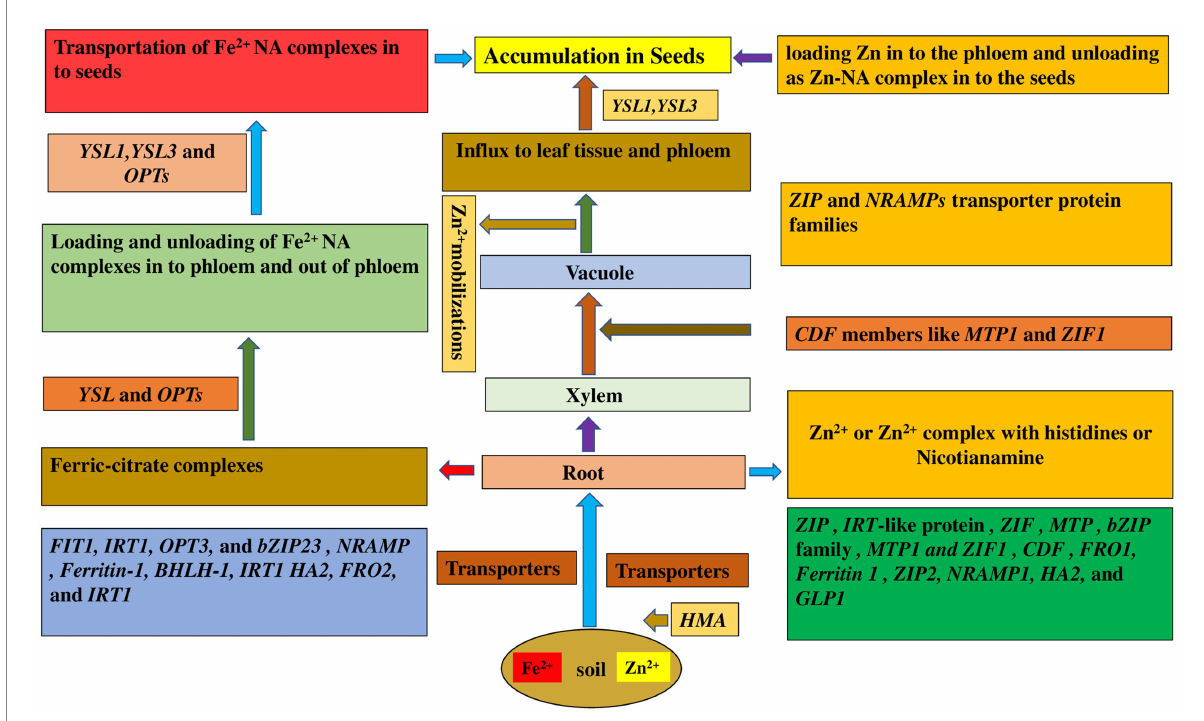
FIGURE 1 Molecular mechanism involved in uptake and acquisition of Fe and Zn in legume seeds. YSL, Yellow Stripe Like; OPT, Oligopeptide transporter; NRAMP, Natural resistance-associated macrophage protein; IRT, Iron regulated transporter; FER, Ferritin; FRO Ferric reduction oxidase; ZIP, Zinc induced protein; HA, H+ transporting ATPase; GLP, Germin like protein; CDF, Cation diffusion facilitator; MTP, Metal tolerance protein; ZIF, Zinc- induced facilitator; BHLH, basic helix–loop–helix; HMA, heavy metal